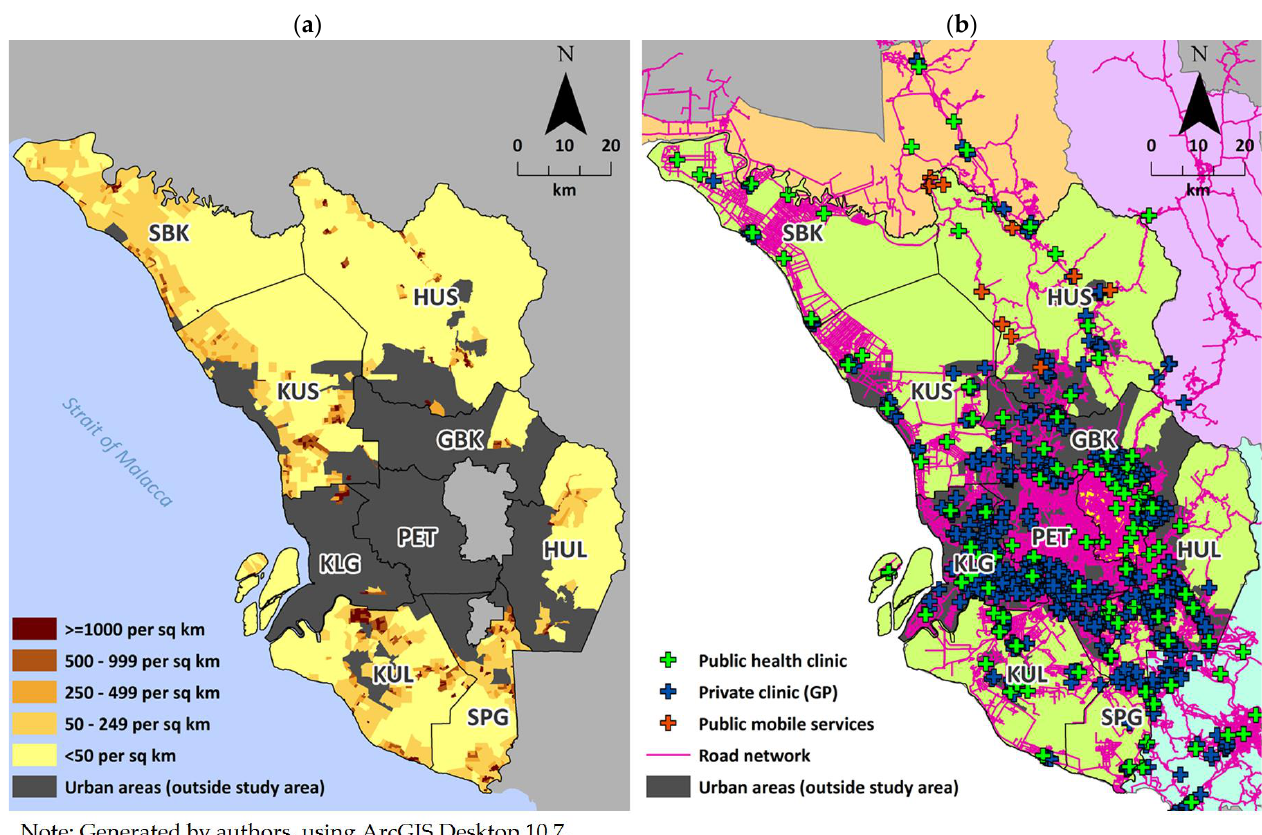
Figure 1. Study area and districts from adjacent district/states. ( a ) Population density (person per square kilometer) of rural Selangor. ( b ) Primary care facility distribution (by clinic type) and road network.